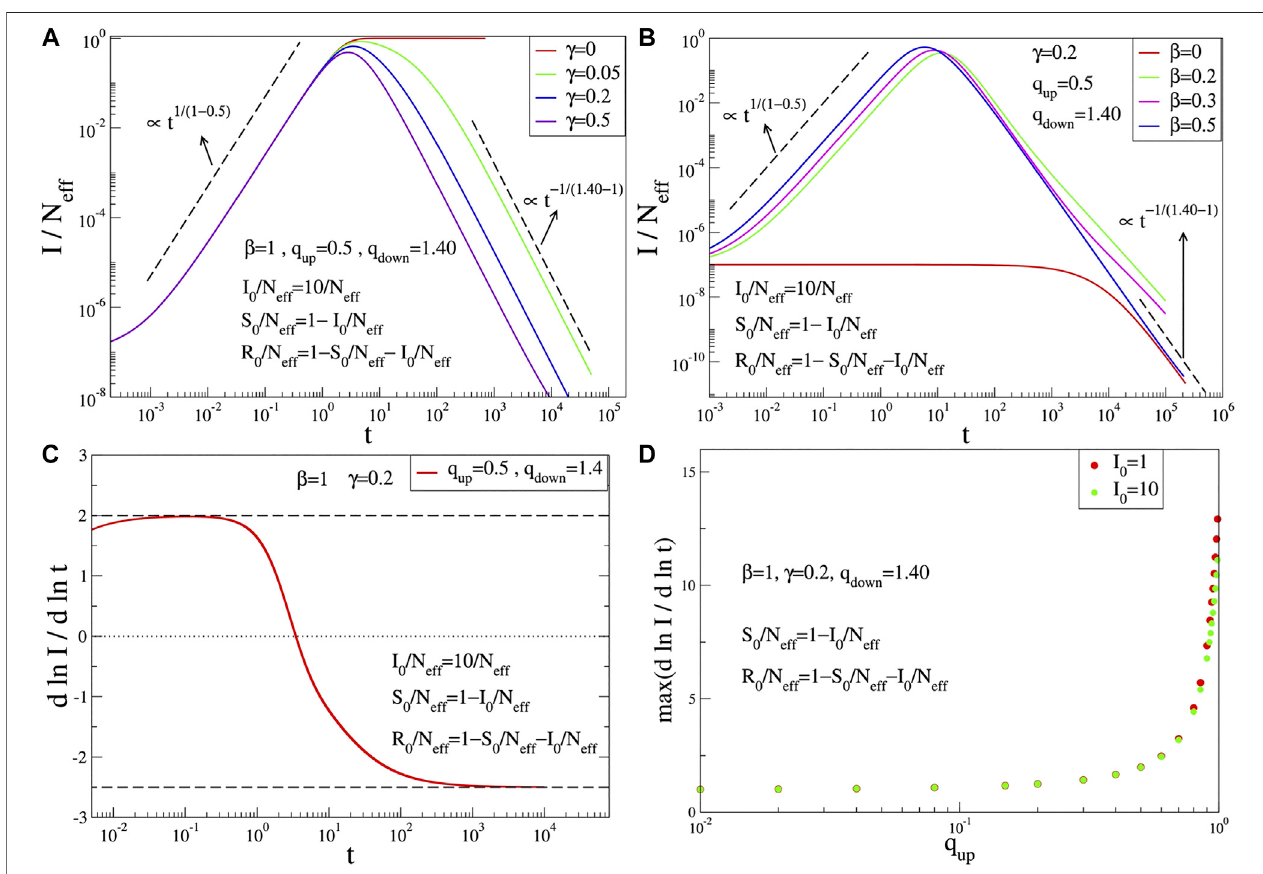
FIGURE 1 | Time evolution of I ( t ) for the q-SIR equations with N eff (cid:2) 10 8 ; we consider t to run virtually from zero to in fi nity (not necessarily during only the typical rangeofrealepidemics,say1,000days). (A) Fixed β andvariousvaluesof c .For c (cid:2) 0and ∀ β , I ( t ) / N eff preciselyrecoverstheexpressiongivenin Eq.(6) .Theslopeatthe fi rst in fl ection point for increasing time is given by max [ d ln I / d ln t ] (cid:2) 1 / ( 1 − q ) , ∀ c . (B) Fixed c and various values of β . For β (cid:2) 0, the q up down -exponential function is precisely recovered. (C) Time dependence of the slope of [ d ln ( I / N eff ) / d ln t ] , which appears to be bounded between 1 / ( 1 − q up ) ( (cid:2) 2 in this example) and − 1 / ( q − 1 ) ( (cid:2) − 2 . 5inthisexample)(dashedlines).Thedottedlinecorrespondstothepositionofthepeakof I ( t ) ,andthemaximum(minimum)correspondstotheleft down (right) in fl ection point. (D) The maximal slope of I ( t ) / N eff as a function of q up . The high value at q up (cid:2) 1 re fl ects the divergence expected in the limit q up (cid:2) q down (cid:2) 1. Indeed, in this limit, the present q-SIR model recovers the standard SIR model, which increases exponentially (and not as a power-law) toward the corresponding peak. Notice also that this slope decreases when I 0 / N eff